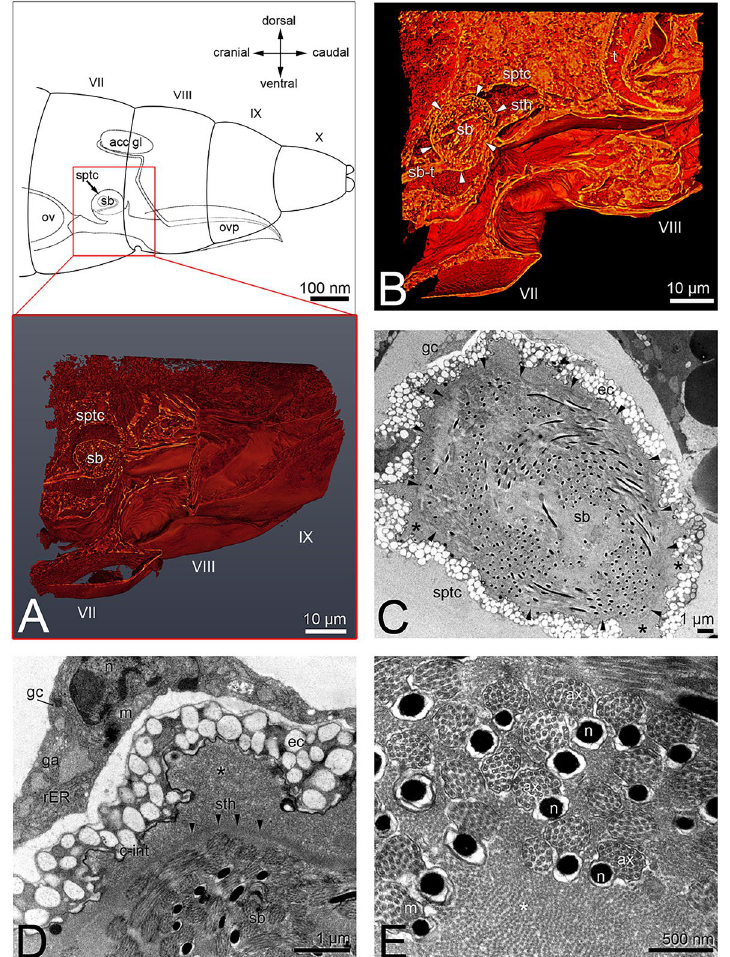
Figure 3. Echinothrips americanus , ( A ) schematic drawing of the spermathecas position within the segment VII and VIII, A inlay: nano-CT image of the region VII to IX with spermatheca and sperm ball inside, ( B ) compact sperm ball made of compressed secretion within the spermatheca, nano-CT; ( C ) spermatheca with sperm ball inside (arrowheads) and secretion (*), ( D ) spermatheca epithelial layer with pigment granules and gland cells, ( E ) spermatozoa within the sperm